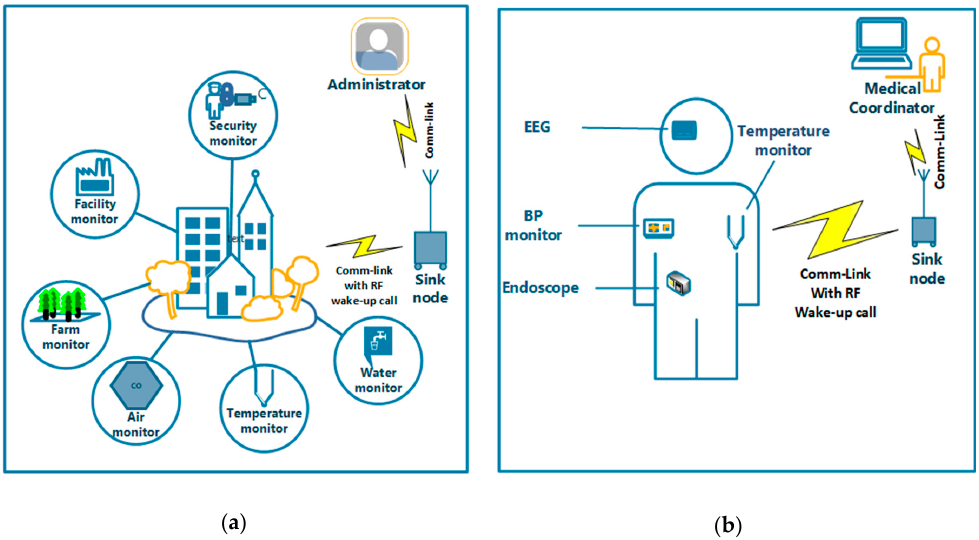
Figure 9. ( a ) Description of passive wake-up radio for remote environmental monitoring. ( b ) of passive wake-up radio for medical Description of passive wake-up radio for medical applications.